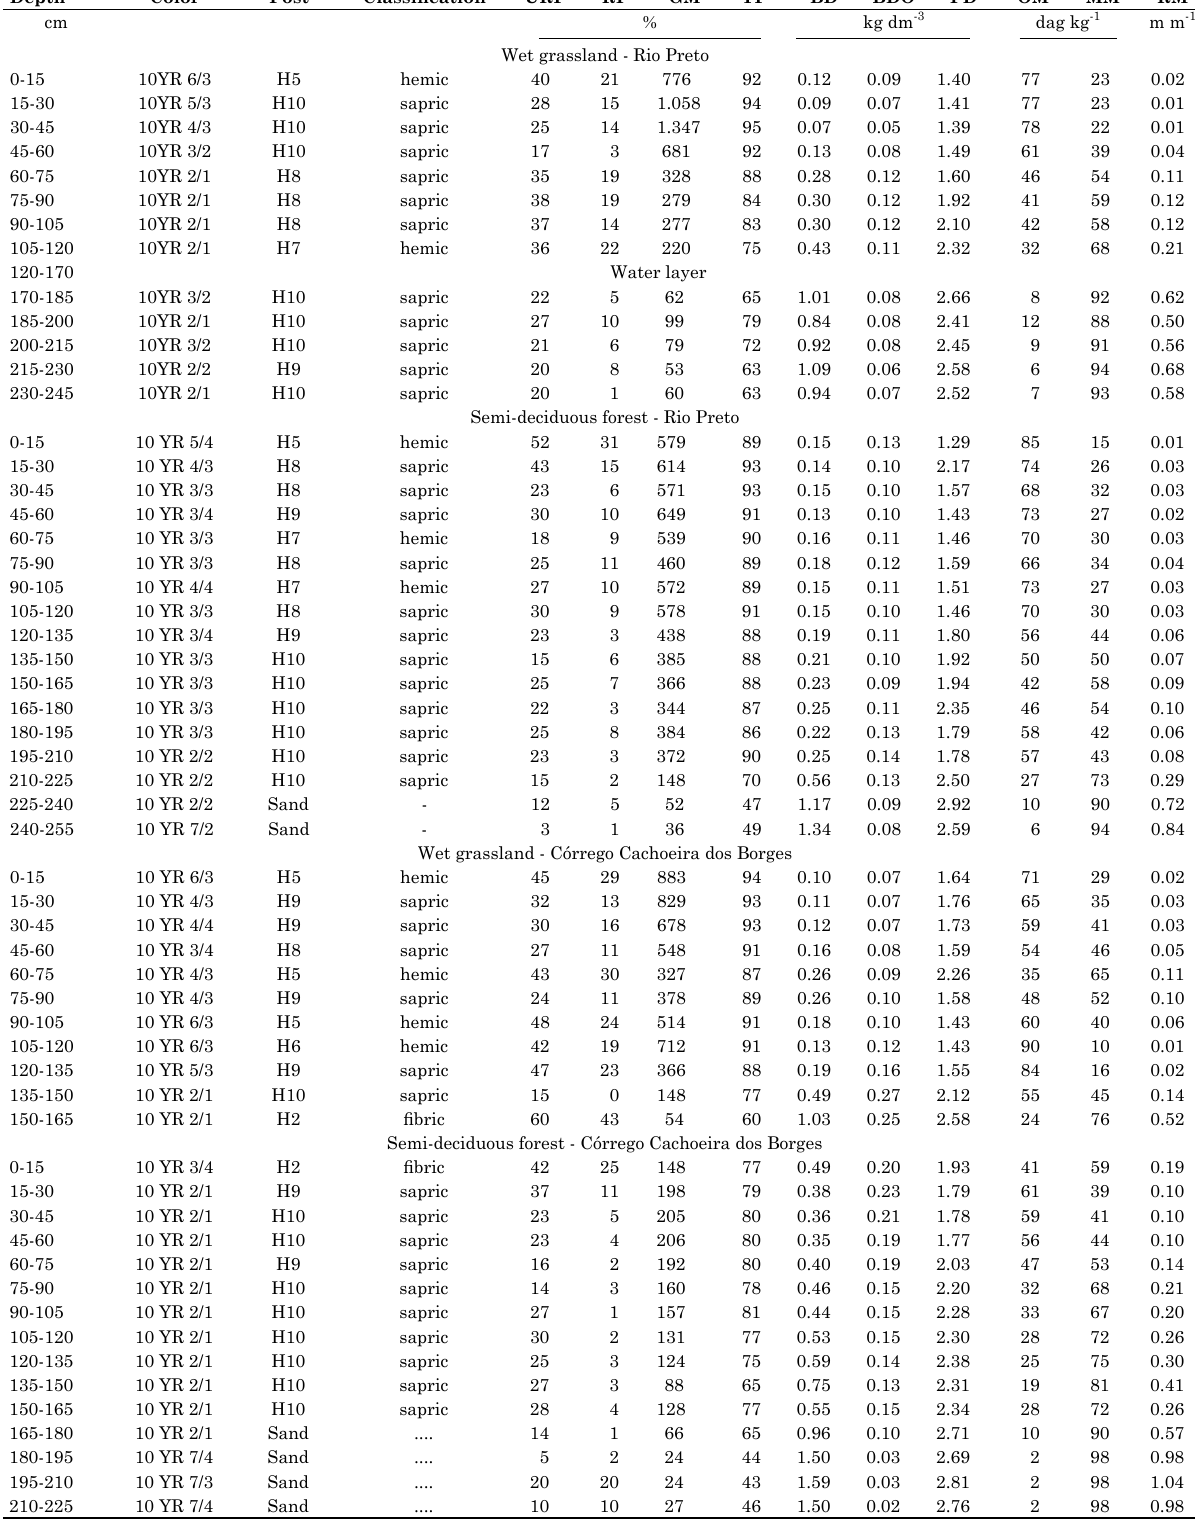
Table 1. Physical and morphological properties of peat soils under two vegetation types from the headwaters of tributaries of the Rio Araçuaí (average of two observations) Depth